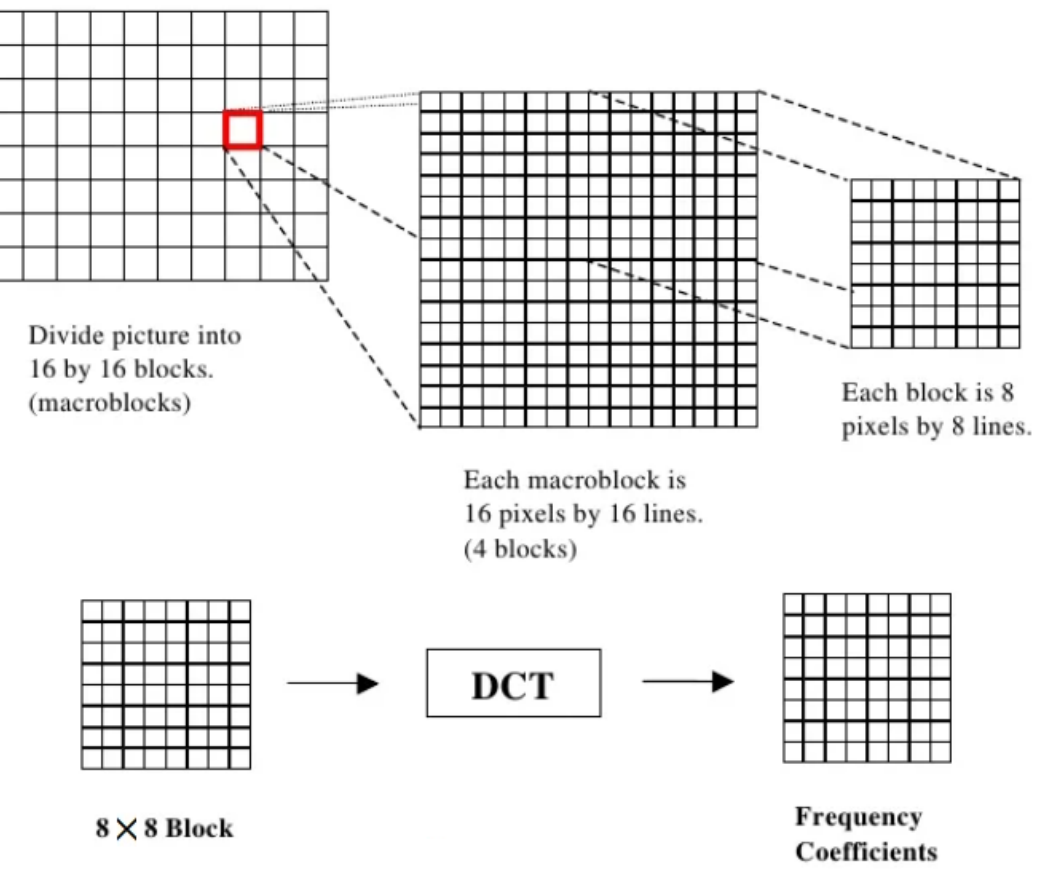
Figure 2. The process of the discrete cosine